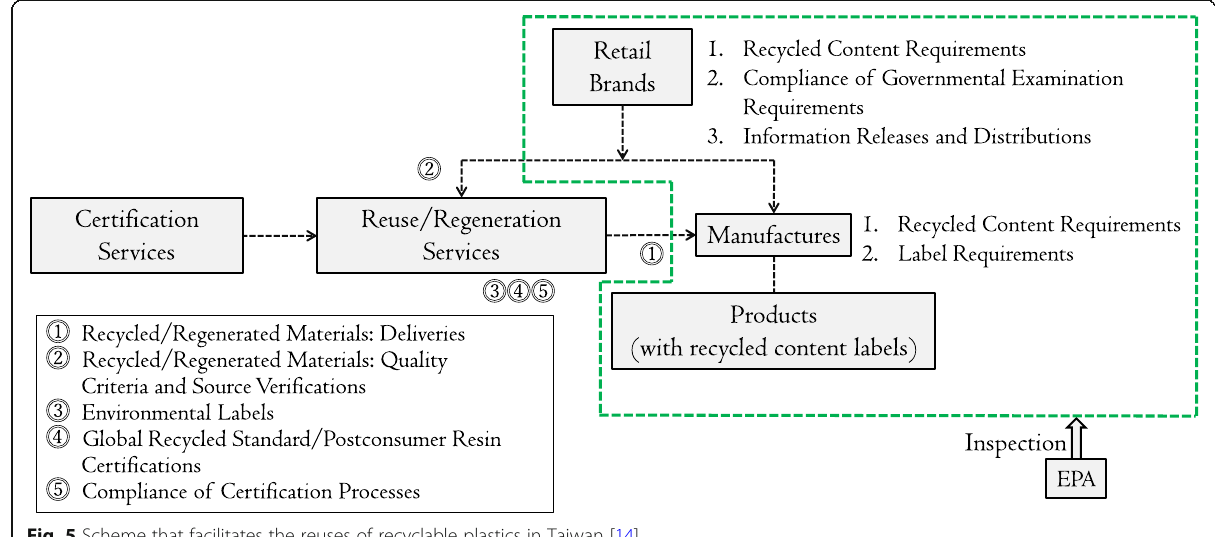
Fig. 5 Scheme that facilitates the reuses of recyclable plastics in Taiwan